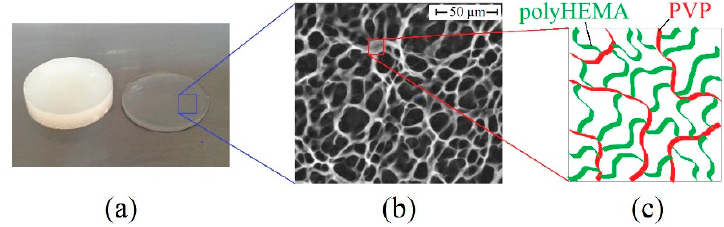
Figure 4. Swollen samples ( a ), SEM image of a porous hydrogel ( b ) and schematic image of the structure of pHEMA-gr-PVP copolymer ( c ) (Composition formulation, mass parts: HEMA:PVP = 80:20).